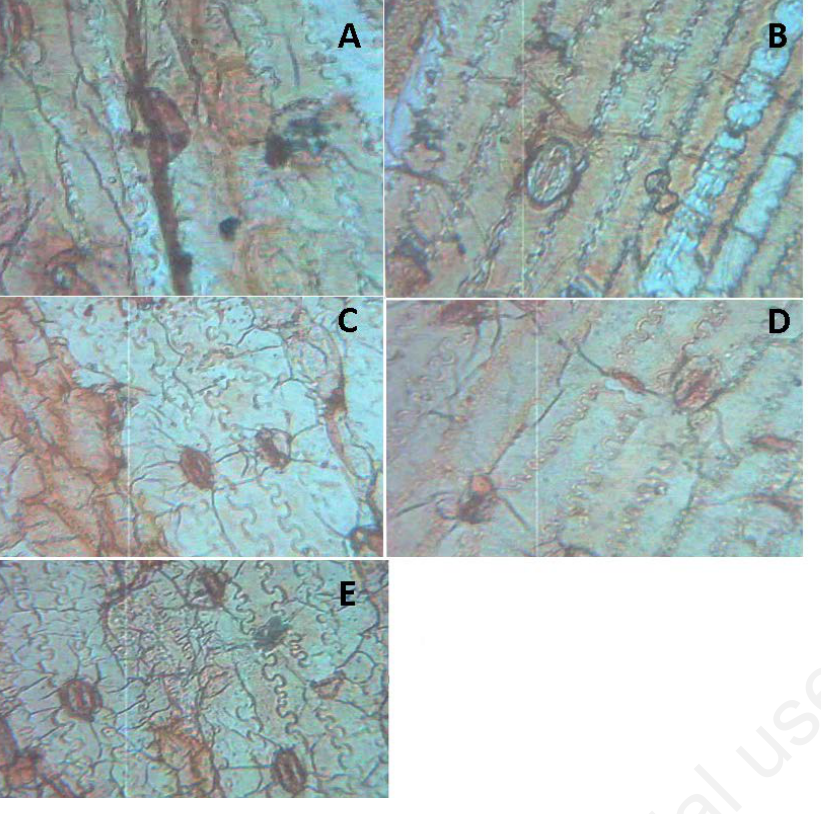
Figure 2. A) Upper epidermal layer guinea corn leave exposed to 5% petrol; B) upper epi- dermal layer guinea corn leave exposed to 10% petrol; C) Upper epidermal layer of guinea corn leave unexposed (control); D) upper epidermal layer guinea corn leave exposed to 20% petrol; E) upper epidermal (Adaxial) layer guinea corn leave exposed to 20% spent